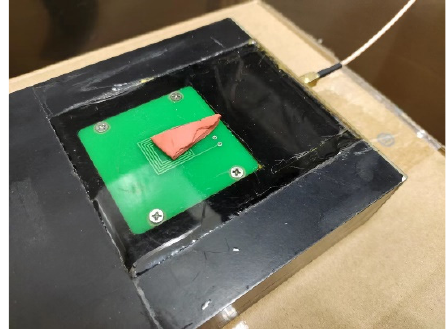
Figure 1. The single sided NMR sensor.